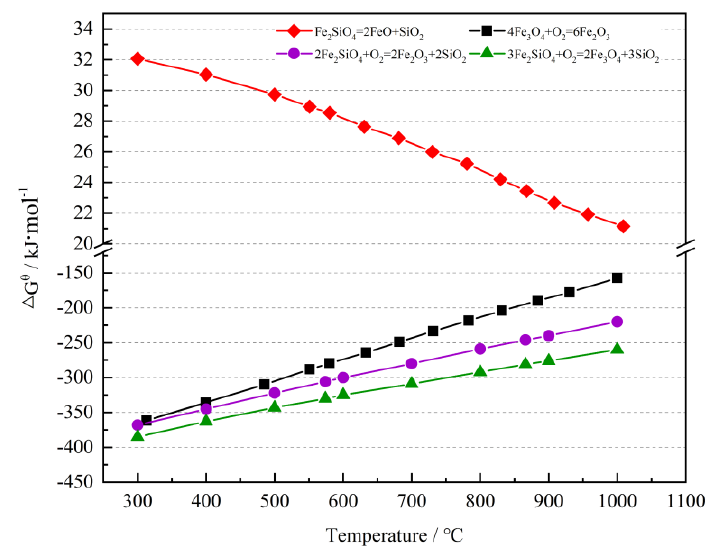
Figure 11. Decomposition of Fe 2 SiO 4 in nickel slag and its standard Gibbs free energy change curve under oxidation atmosphere.